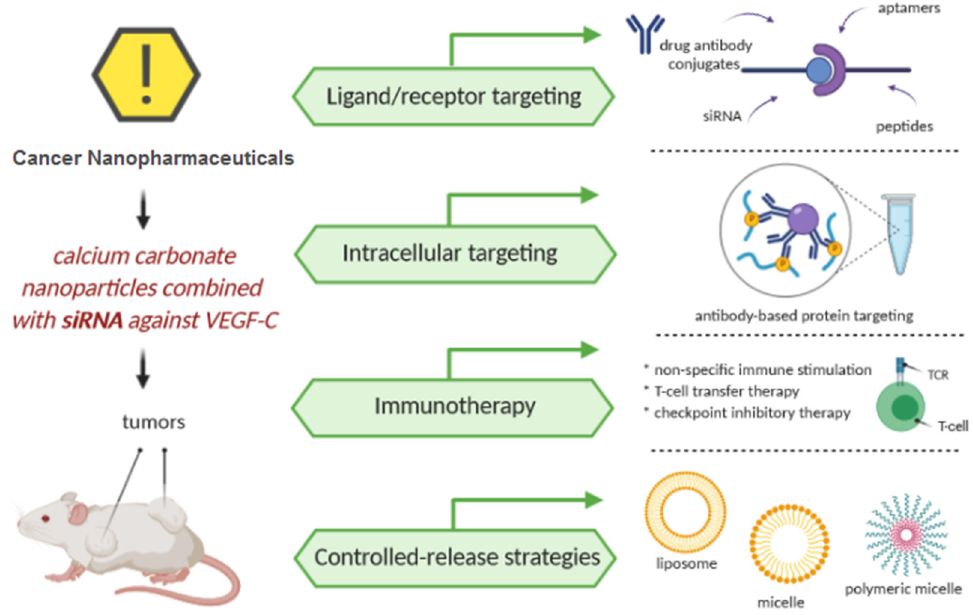
Figure 6. Graphical summary of the chosen methods towards development of the efficient and safe cancer nanotherapeutics [own drawing].